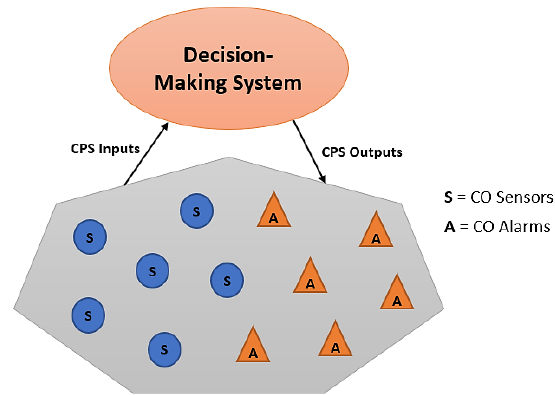
Figure 2. Example CPS based framework for carbon monoxide detection and control.